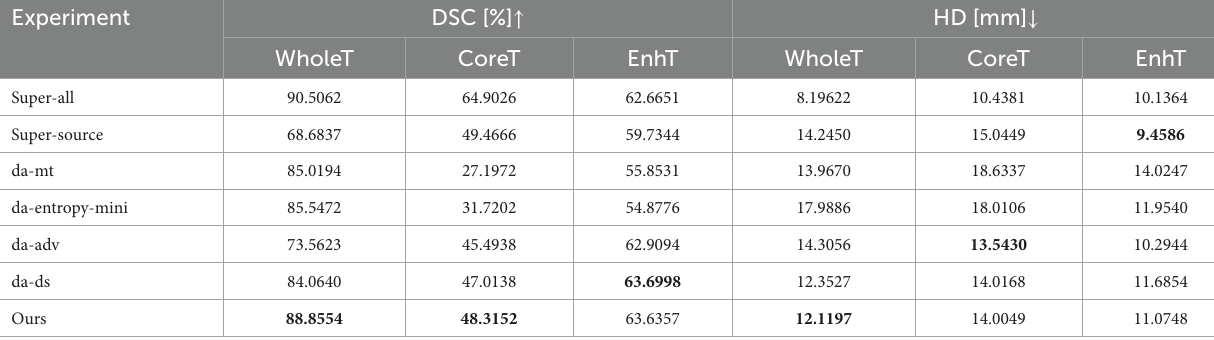
TABLE 1 Quantitative comparisons of DSC and HD in the HGG-to-LGG UDA task.